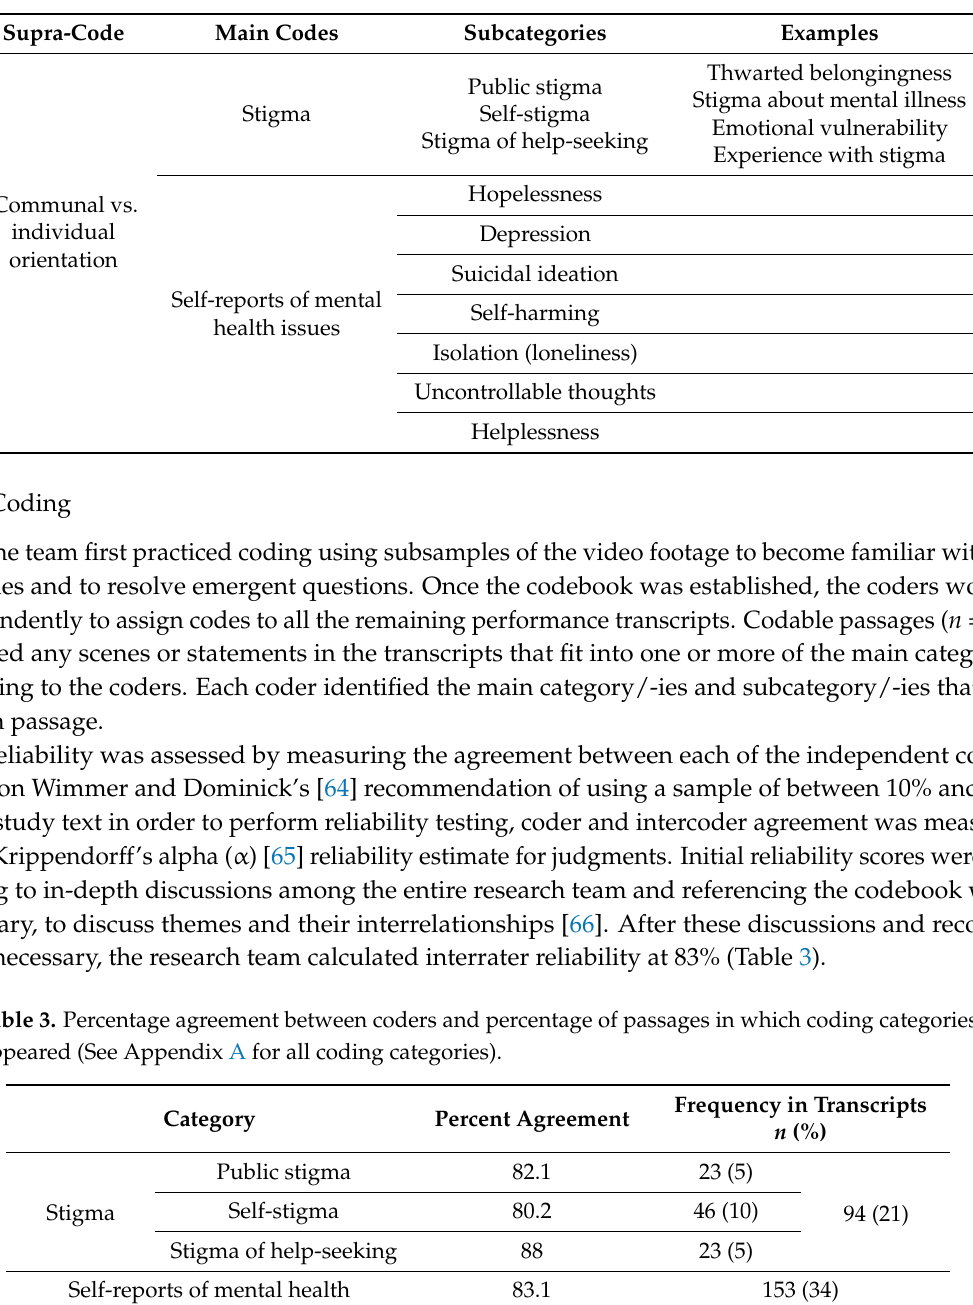
Table 2. Main coding categories, subcategories, and descriptive themes.